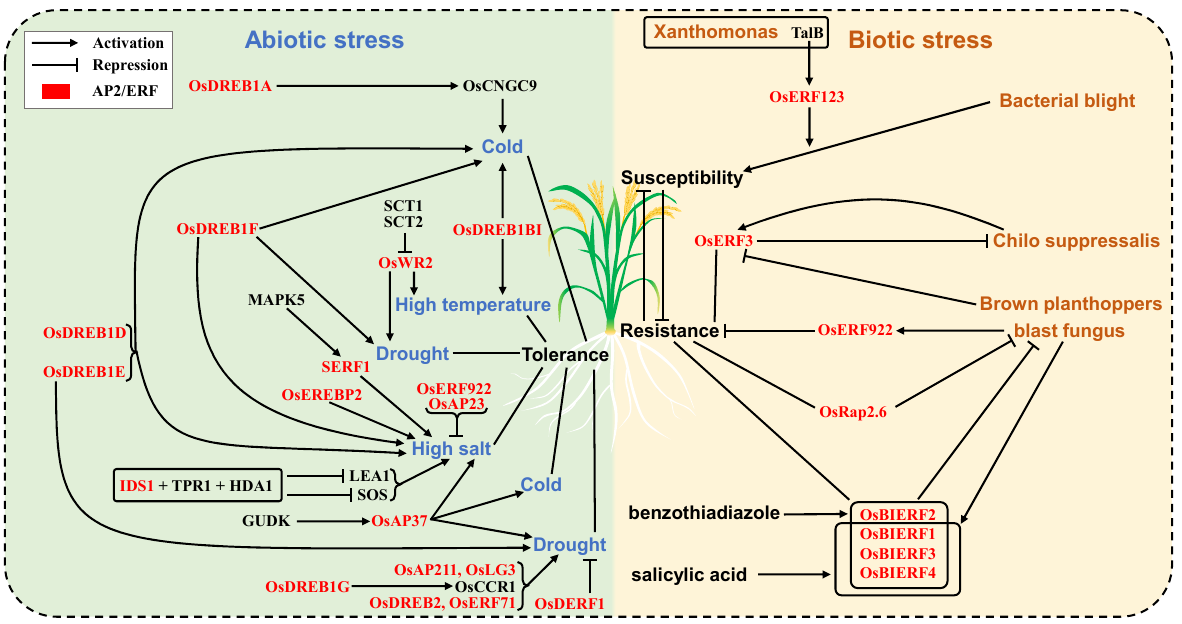
Figure 5. Schematic representation of AP2/ERF transcription factors involved in abiotic and biotic stress regulation in rice. Left are the AP2/ERF regulatory networks of cold, high temperature, high salt and drought tolerance in rice; these factors are discussed in Section 3.8.1. OsDREB1A/D/E/F, OsDREB1BI and OsAP37 promote rice cold tolerance. OsDREB1BI and OsWR2 promote rice high temperature tolerance. OsDREB1E/F/G, OsDREB2, OsWR2, OsAP37, OsAP211, OsLG3 and OsERF71 promote rice drought tolerance, while OsDERF1 inhibits drought tolerance. OsDREB1D/E/F, SERF1, OsEREBP2, OsAP37 and IDS1 promote rice high salt tolerance, while OsERF922 and OsAP23 inhibit high salt tolerance. On the right, AP2/ERF genes participate in the regulation of disease and insect resistance in rice; these factors are discussed in Section 3.8.2. TalB, which is a transcriptional activator effector in Xanthomonas, promotes rice susceptibility to bacterial blight fungus X11-5A by promoting OsERF123 . OsERF3 is activated by Chilo suppressalis attack, which improves rice resistance against chewing herbivores but is slightly suppressed by brown planthoppers attack. OsRap2.6 promotes rice blast fungus resistance, while OsERF922 inhibits rice blast fungus resistance. OsBIERF1/2/3/4 is involved in the rice blast defense response, and among them OsBIERF1/2/3/4 can be induced by benzothiadiazole, and OsBIERF1/3/4 can be induced by salicylic acid and blast fungus. The AP2/ERF transcription factors and other regulators are shown in red and black, respectively. Table 9. Genes associated with abiotic stress in rice.